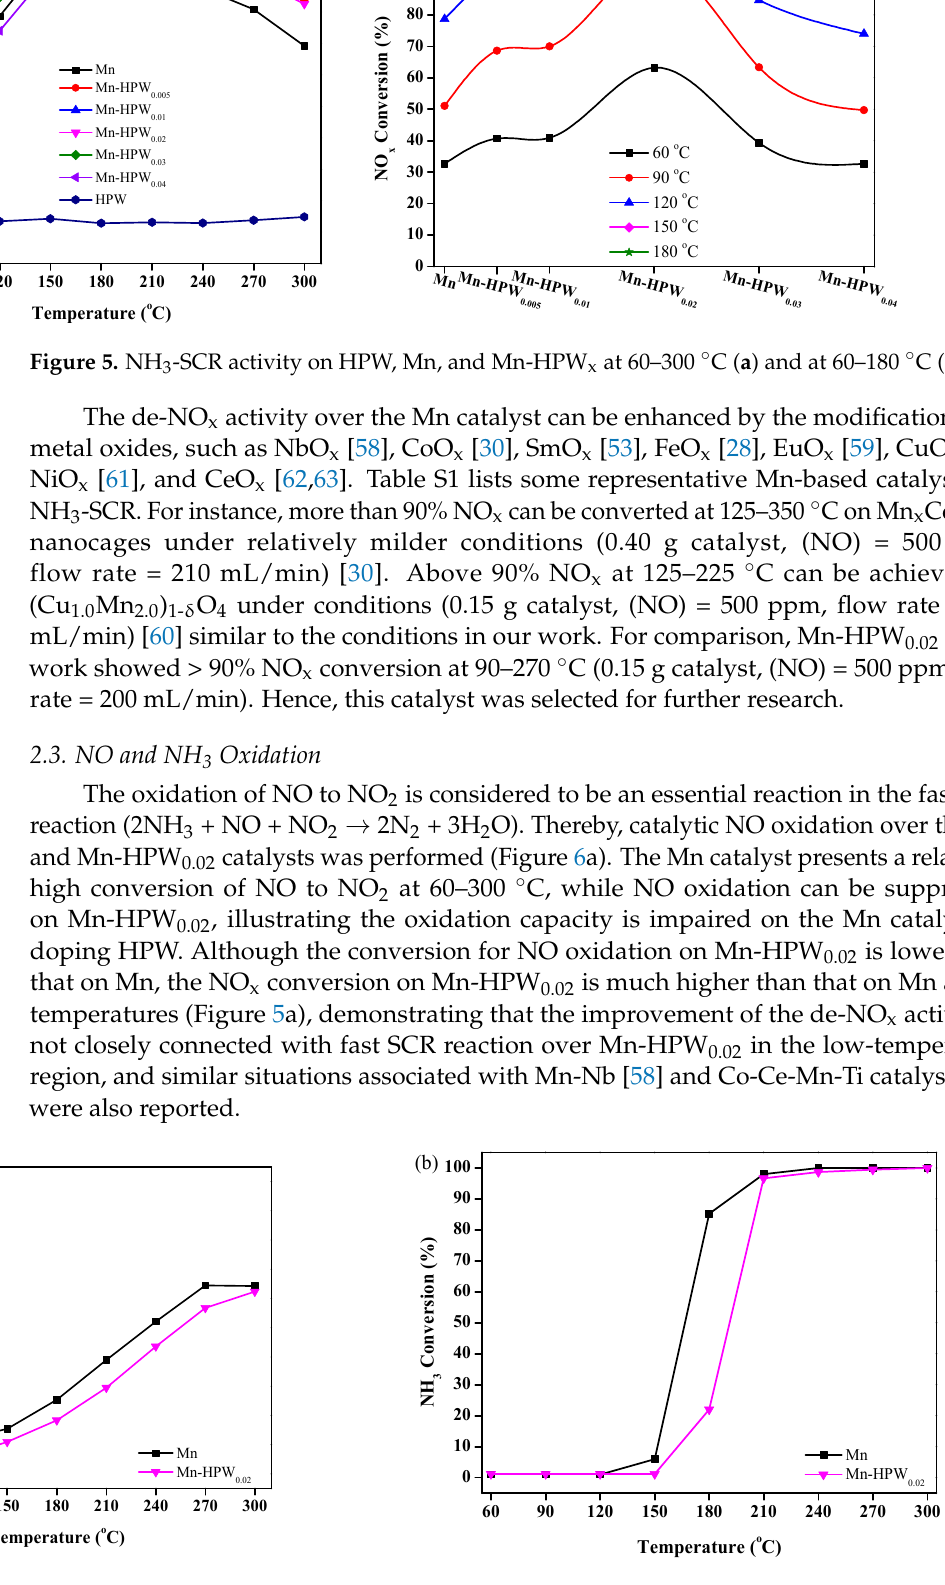
Figure 6. Conversion of NO to NO 2 ( a ) and NH 3 conversion ( b ) on Mn and Mn-HPW 0.02 at 60–300 ◦ °C.